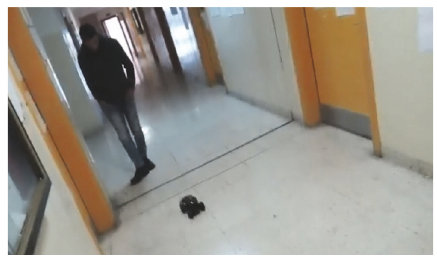
Figure 28: The second tested scenario.